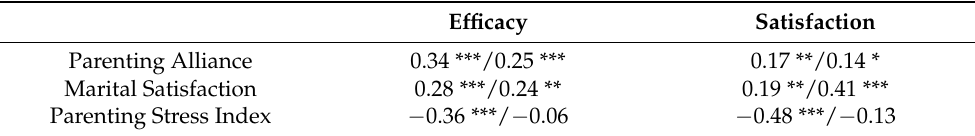
Table 5. PSOC criteria validity in at-risk (N = 273) and community (N = 205) sample.